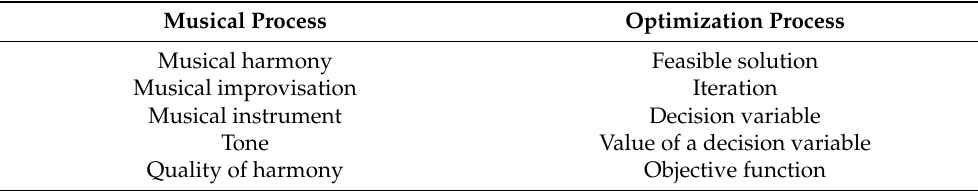
Table 4. Comparison between musical and optimization